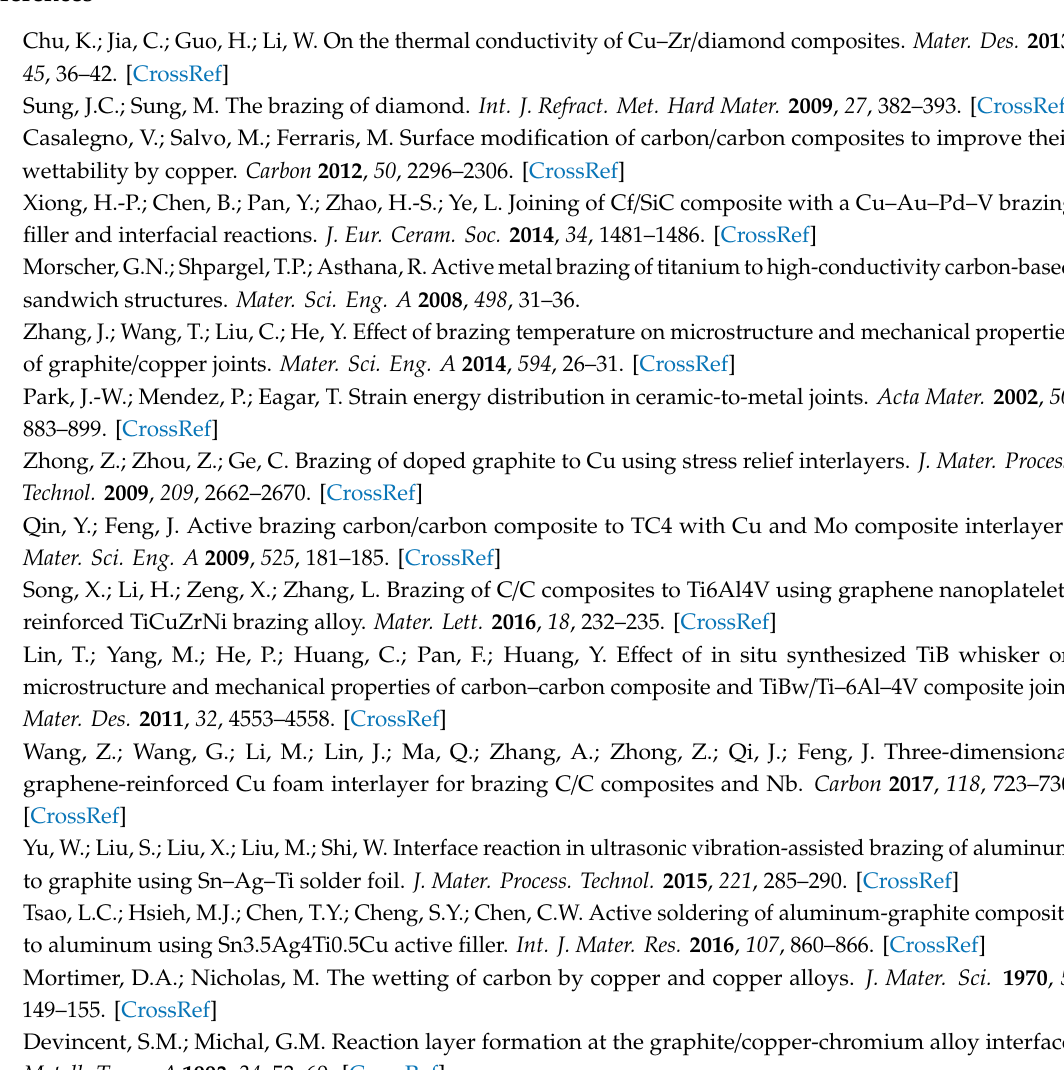
Figure S1: The cross-sectional microstructure of Sn-1 / 3 / 5 alloy / graphite samples cooling from 950 ◦ C, Figure S2: Cross-sectional SEM images of the reaction interfaces at the center of droplet of (a) Sn-0.5V, (b) Sn-1V, (c) Sn-3V, (d) Sn-5V, and (e) Sn-7V, Figure S3: XRD patterns obtained at the interface between Sn-0.5 / 3 / 7V alloy and graphite after wetting at 950 ◦ C, inserted with the top-view of Sn-3V / graphite wetting sample after deeply etching, Fugure S4: XRD patterns obtained at the reaction interfaces between Sn-3V alloy and graphite after wetting at 750, 800, 850 and 900 ◦ C. The residual Sn-V alloys at the reaction interface were removed by an HCl